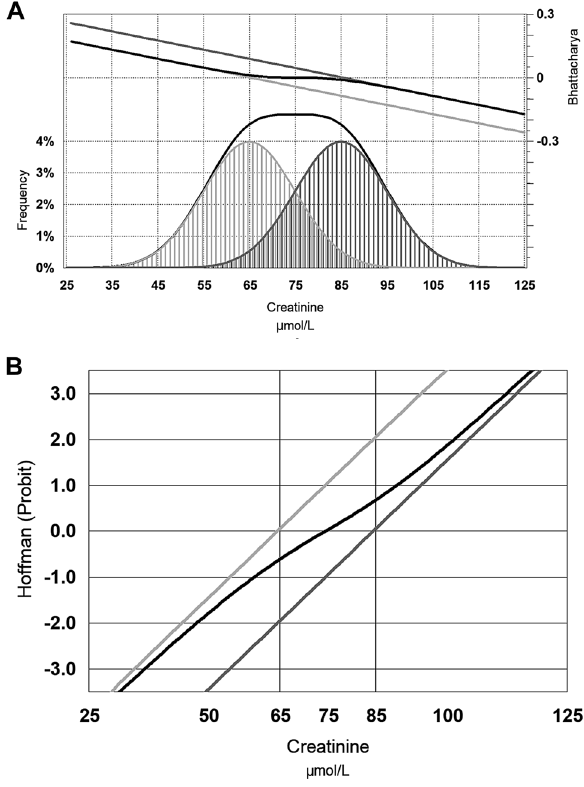
Figure5: Distributionoflaboratoryserumcreatinineinyoungadults between20and29yearsof age;men(darkgrey),women(lightgrey) and the combined distribution of men and women (black line). Panel (A) also showsthe Bhattacharya functionfor each distribution and the combined distribution, while panel (B) shows the Hoffmann function (see text for further